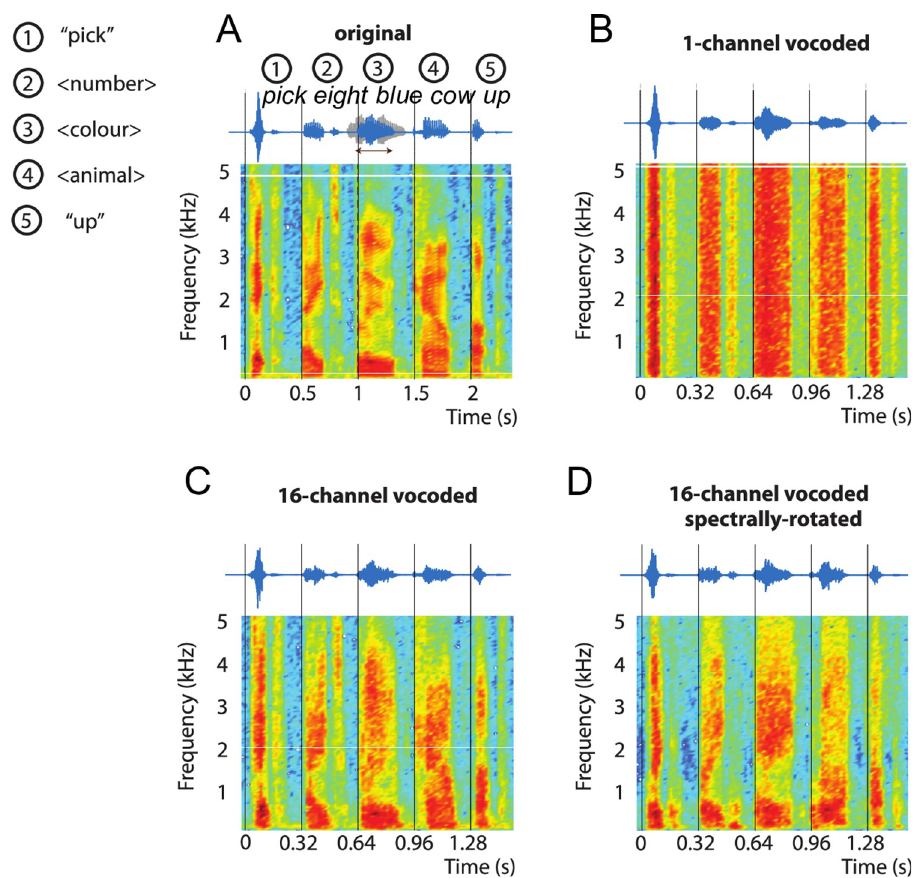
Fig 1. Stimuli used in Experiments 1 and 2. The original speech (A) consisted of five one-syllable words, spoken at 2 Hz based on a metronome beat. This led to perfectly rhythmic speech, based on perceptual terms, with p-centres aligned with the metronome beats (vertical lines). First and last words of the five-word sequence were always “pick” and “up”, respectively. The other three words were a number, colour, and animal, with eight possible options for each (see Experiment 1, Materials)–“pick eight blue cow up” for all panels in this figure. Original speech was time- compressed to 3.125 Hz for all experiments. In 50% of the trials, the second, third, or fourth word was shifted by ± 68 ms to create an irregularity in the stimulus rhythm which participants were asked to detect (example waveforms shown in grey marked with an arrow). For Experiments 1 and 2, stimuli shown in A were modified using noise-vocoding, yielding unintelligible 1-channel vocoded speech (B) and intelligible 16-channel vocoded speech (C) (Experiment 1, Materials). For Experiment 2 only, amplitude envelopes extracted for the construction of noise-vocoded speech were rotated before being applied to noise, yielding unintelligible, but spectrally complex, 16-channel rotated speech (D) (Experiment 2, Materials). hit probability and false alarm probability: